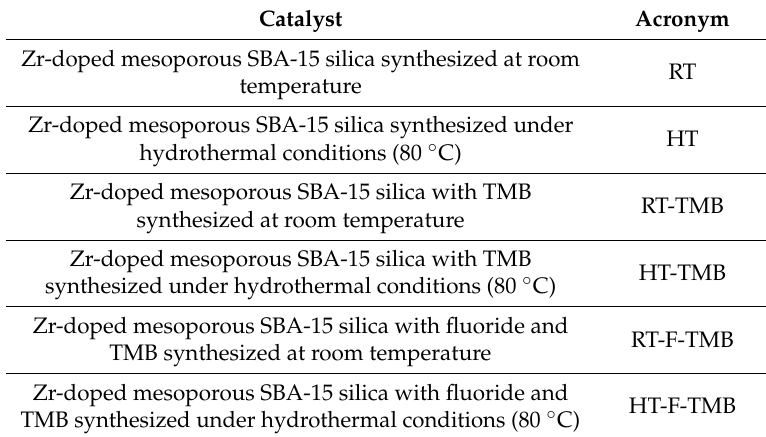
Table 3. List of acronyms of the Zr-doped mesoporous SBA-15 silica used in the MPV reaction of